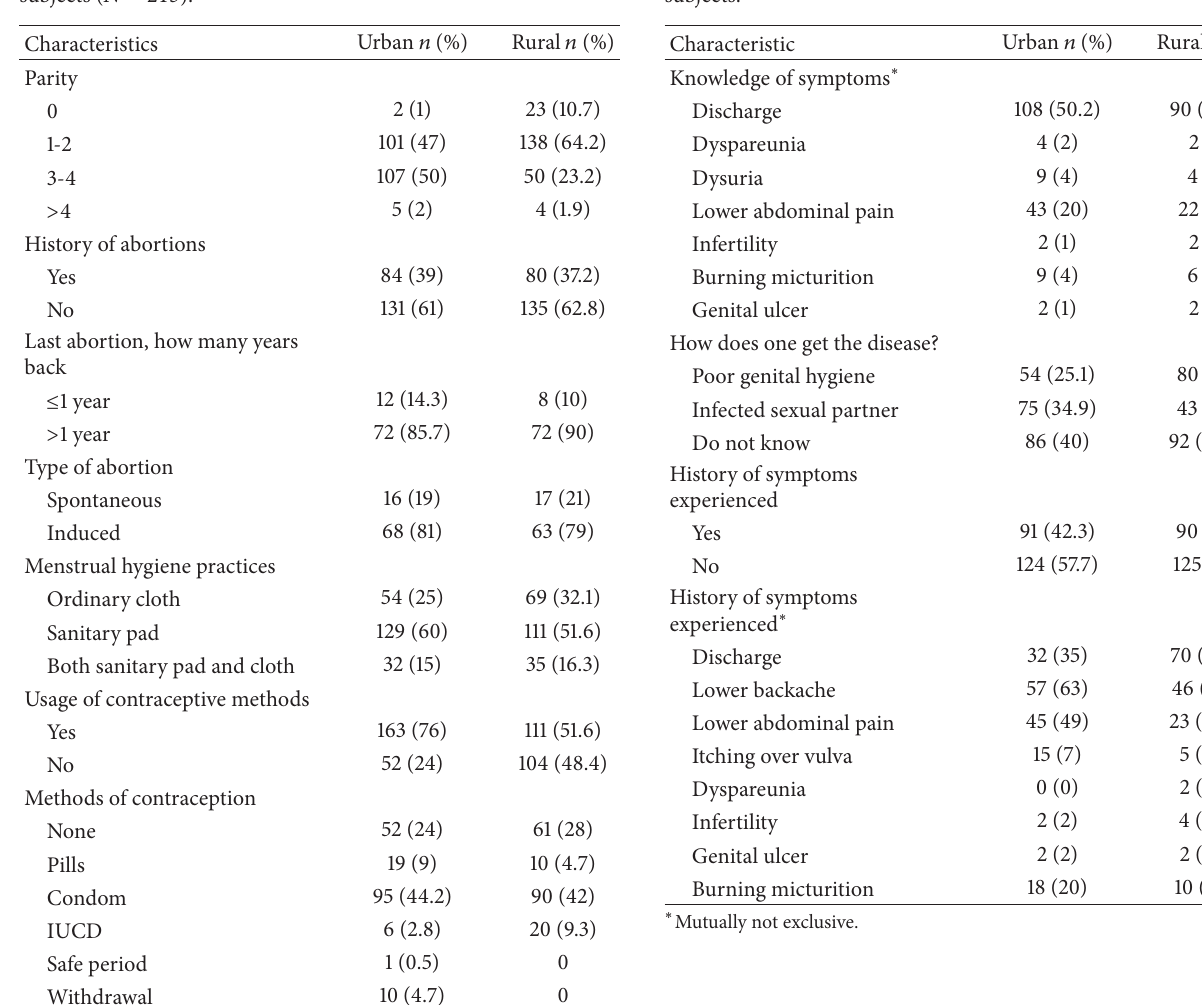
Table 2: Obstetric and behavioural characteristics of the study subjects ( 𝑁 = 215 ).